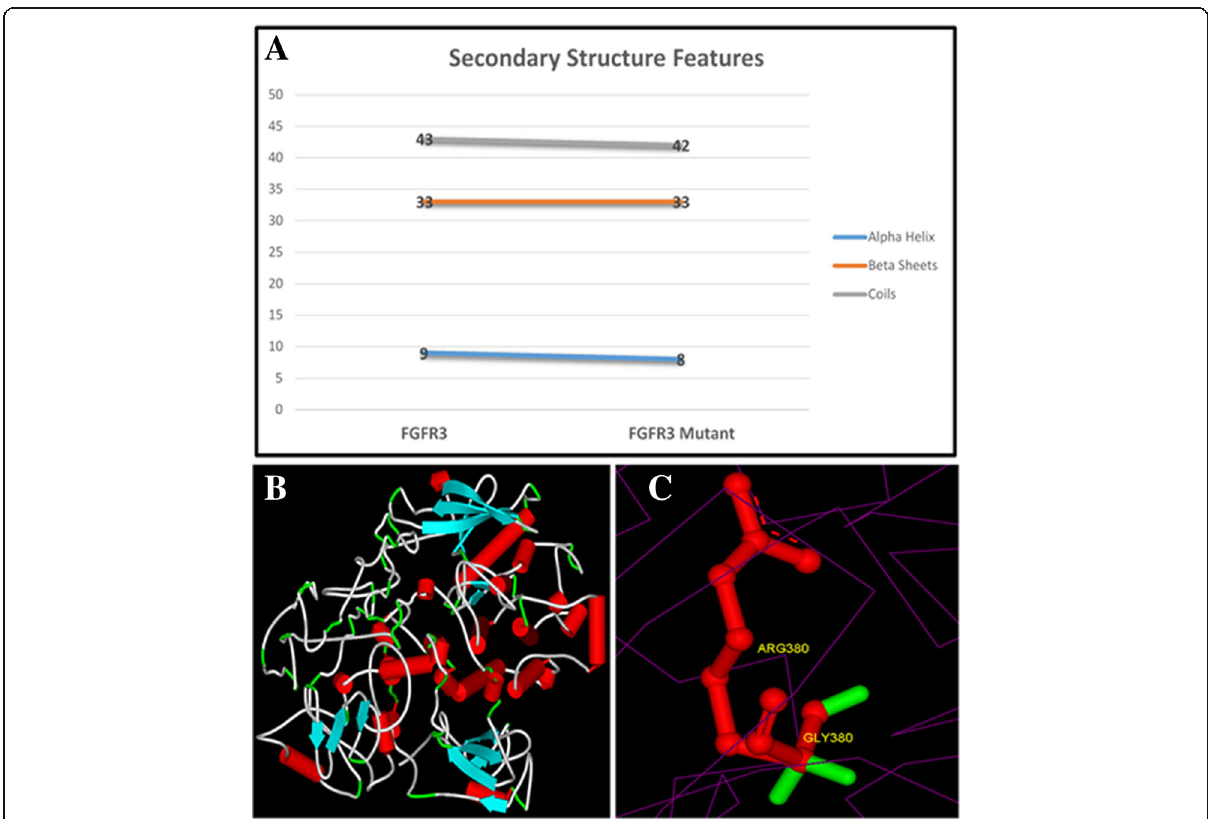
Fig. 3 Structure modeling: ( a ) PsiPred results showing number of secondary structure features in the wild-type and mutant forms of FGFR3. b Three-dimensional structure prediction of wild-type FGFR3 using I-Tasser. Red cylinders showing α -helix, flattened cyan color arrows showing β - Sheets and rest tube like features are coils. c Superimposed three-dimensional structures of wild-type and mutant highlighting the substituted amino acid. Superimposed structures represented by purple wire display style while red ball & stick model is representing arginine which got substituted by glycine (green color stick display style) at 380 amino acid position (p.G380R)